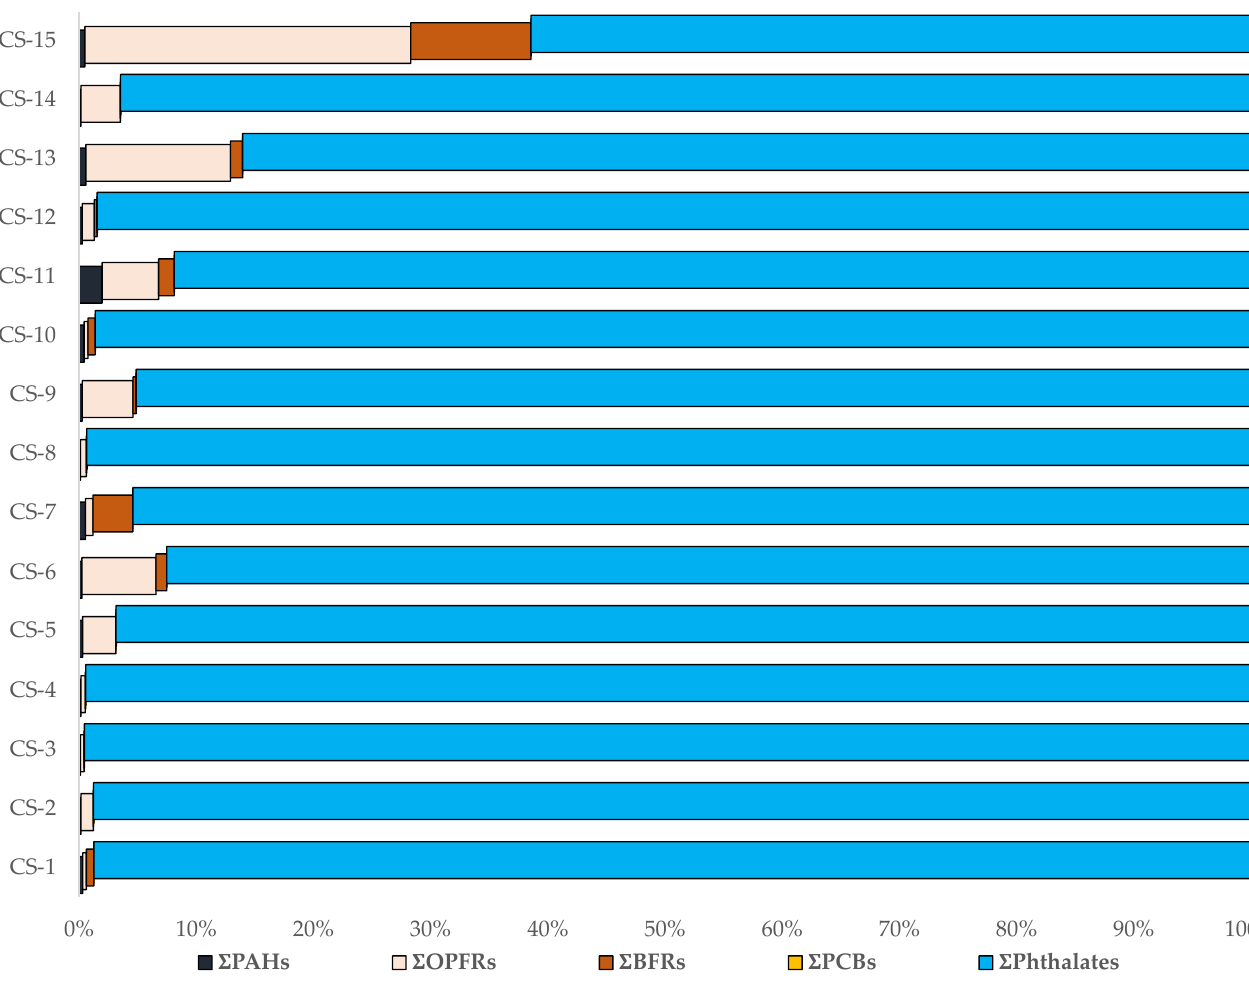
Figure 1. Contribution of each group of chemicals in the dust chemical profile of the 15 individual car dust samples. Values on the X -axis are given in ng/g of dust, while the Y -axis represents each car dust sample’s ID, CS represent “car sample”.